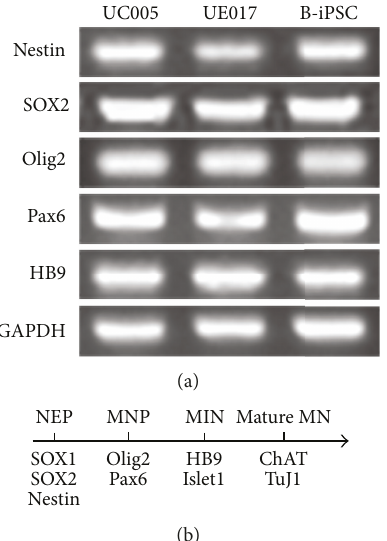
Figure 4: (a) PCR analysis of the mRNA expression levels of neural cell markers at every di ff erentiation stage. After 7 days of di ff erentiation, both B-NEPs and urine-NEPs expressed the neural markers, Nestin and SOX2. After an additional 6 days of induction, cells derived from all three iPSC lines expressed the MNP markers, Olig2 and Pax6. As early as day 19 of induction, MNs from B-iPSCs and urine-iPSCs expressed the MN-speci fi c marker, HB9. These mRNA expression results were consistent with the results of protein expression, as shown by immuno fl uorescence. (b) Stages of di ff erentiation of MNs from iPSCs and markers commonly used for their